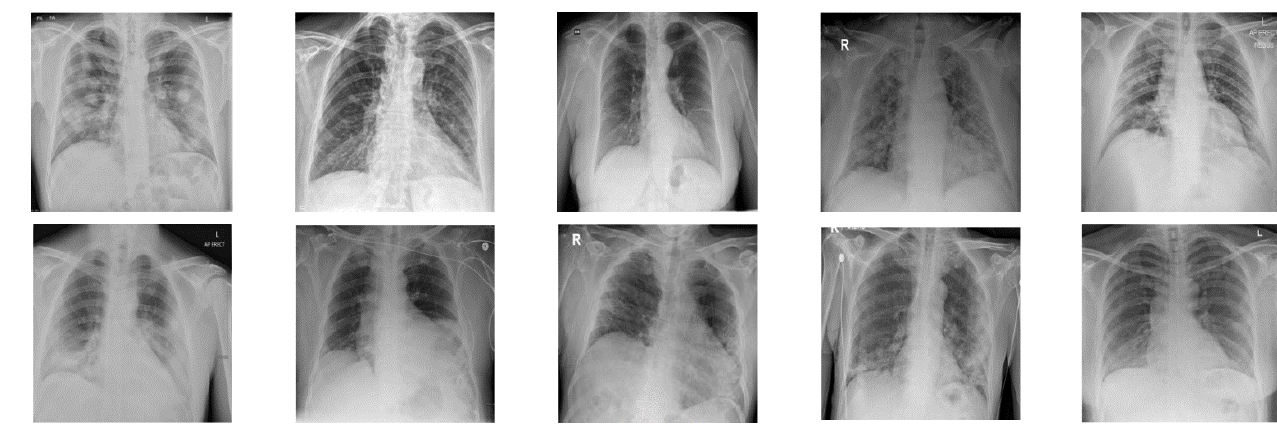
Figure 12. X-Ray images used in the proposed method.